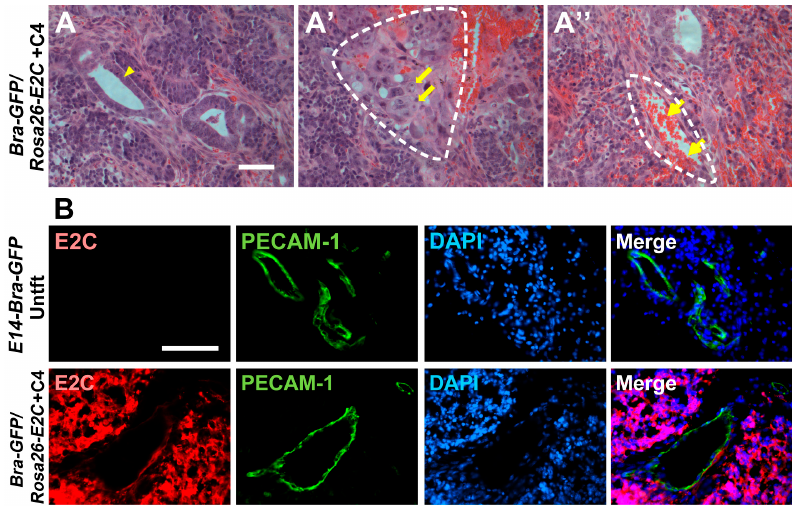
Figure 6. Histopathology and immunofluorescence analyses of tumours derived from the mESCs. ( A – A ′′ ) Haematoxylin and eosin (H&E) staining was performed on paraffin sections prepared from the day-9 tumours. Arrow heads show epithelial structure ( A ), thick arrows show chondrocyte-like cells ( A ′ ) and thin arrows show red blood cells ( A ′′ ). Dashed lines show the structures of chondrogenic-like (mesoderm-like) differentiation ( A ′ ) and blood vessels ( A ′′ ); ( B ) Immunostaining for E2C (red) and PECAM-1 (green) in tumours derived from Bra-GFP/Rosa26-E2C mESCs or untransfected controls (Untft). Dual immunostaining of frozen sections prepared from tumours harvested at day 9 showed that all cells, except the vasculature and blood cells, within the tumours were derived from the E2C + mESC, which stained positively for E2C. On the other hand, the endothelial cells within the tumours did not stain positively for E2C, indicating they were derived from the host animals. Tumours developed from the untransfected E14-Bra-GFP mESCs were used as controls. Scale bars, 50 µm ( A – A ′′ ); 100 µm ( B ).